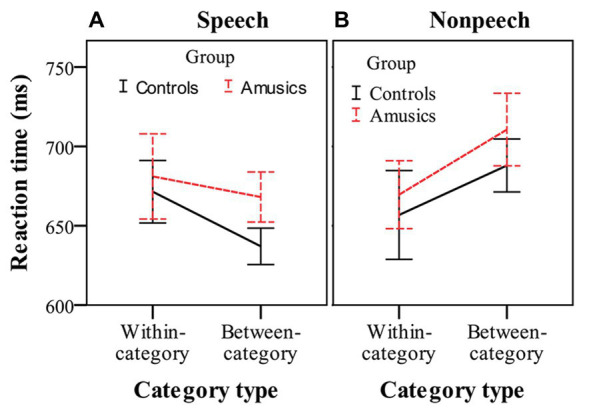
Reaction times in response to within-category and between-category deviants in speech (A) and nonspeech (B) contexts for the controls (black solid lines) and amusics (red dashed lines). Error bars: +/−1 standard error.